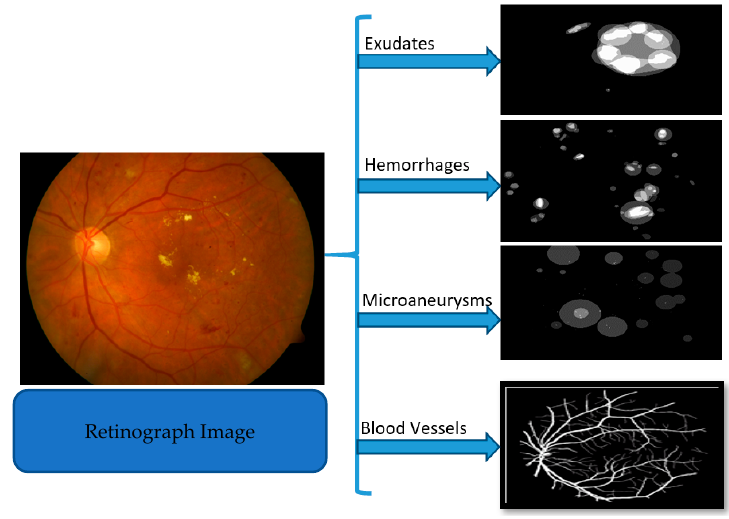
Figure 2. Example of HR fundus photo used to train the CAD-HR-diagnosis system.